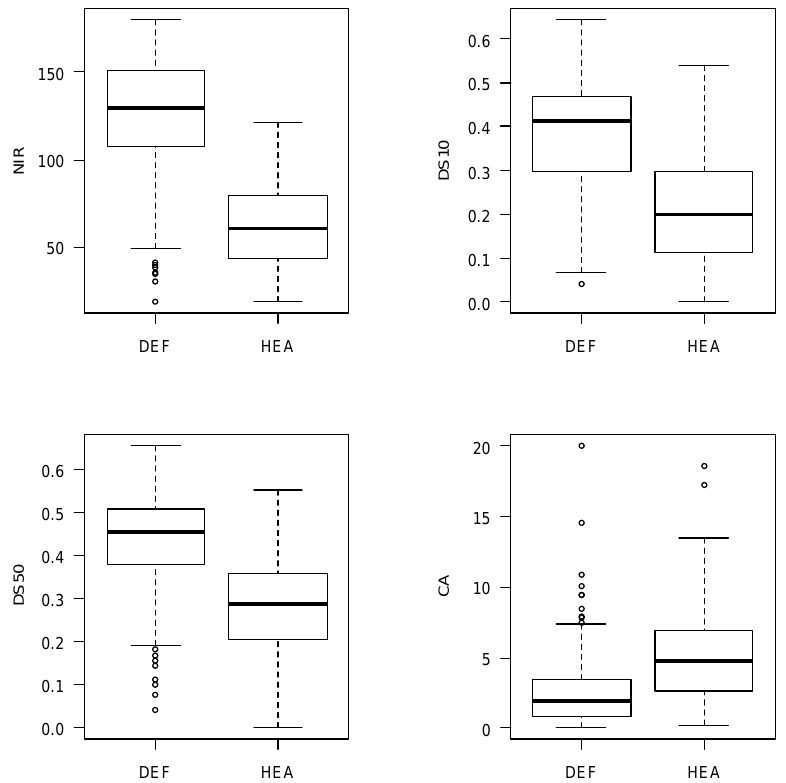
Figure 3. NIR, DS10, DS50 and CA features used in the classification of defoliated (DEF) and healthy (HEA) trees. Table 2 describes the features.